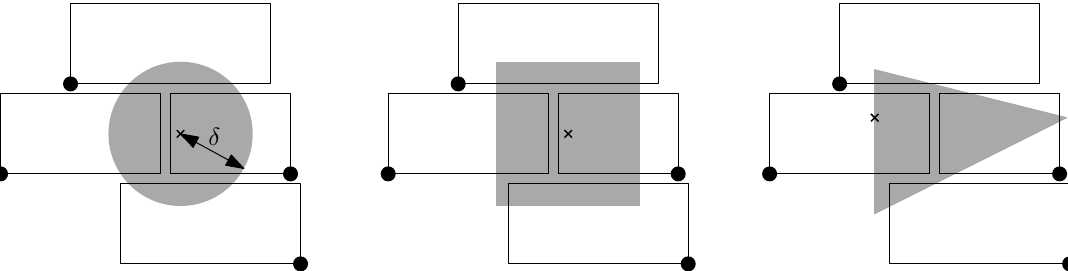
Figure 3. ( left ): a labeling of four labels that intersect a disk of radius δ ; such a solution can be avoided with our model by defining Γ as a disk of radius δ centered in ( 0,0 ) and K Γ = 3; ( middle ): the same situation with a square-shaped region Γ , which is the setting that we used in our experiments; ( right ): the same situation with a triangular region Γ —we use this setting in the following discussion to show that Γ is not required to be